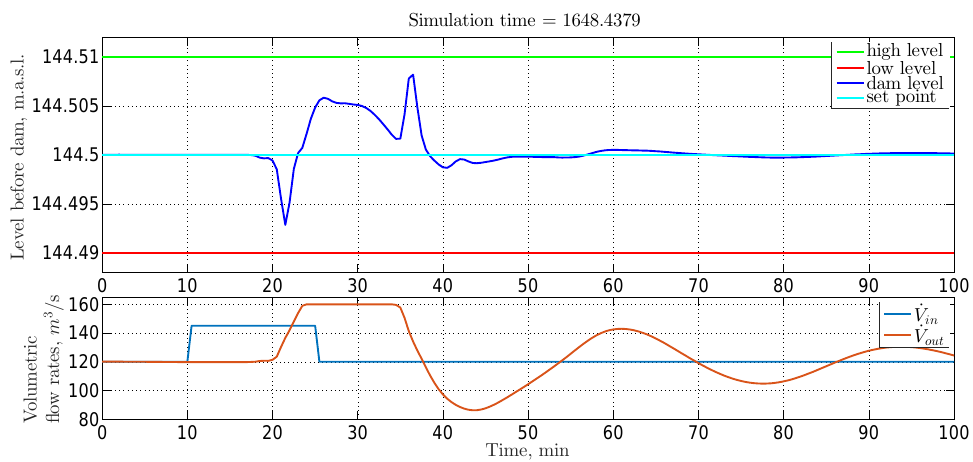
Figure 12: The results of simulation of MPC ( λ e = 2 . 86 · 10 6 , N = 10 and T s = 30).